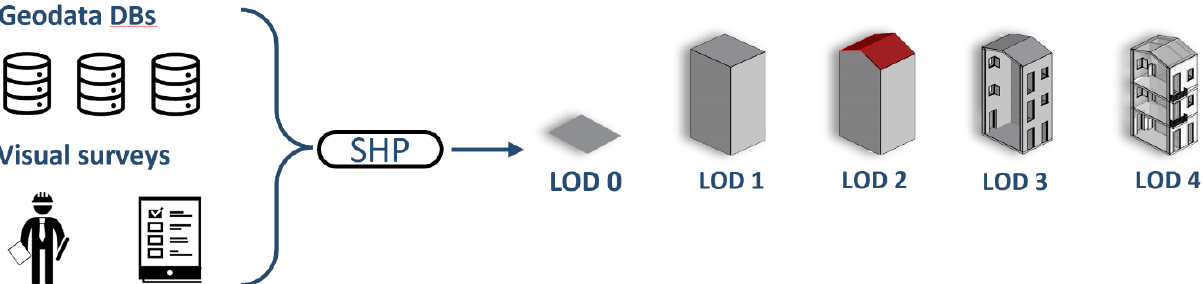
Figure 2 . Conceptual scheme of the suggested procedure. The operator only needs to compile a